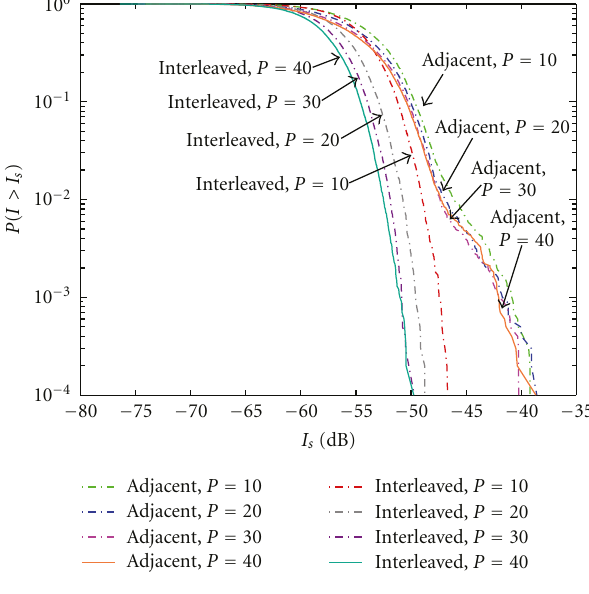
Figure 6: DPSO PTS-AIC with di ff erent number of particles, P . N b = 16, N w = 2. Q = 20.